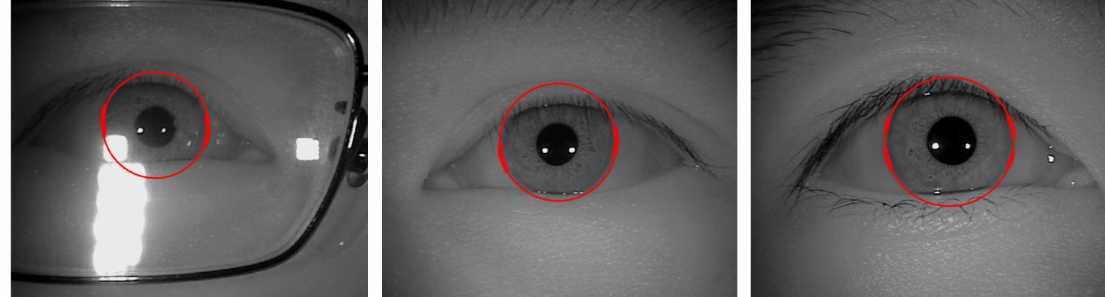
Figure 9. Example results of outer boundary estimation.